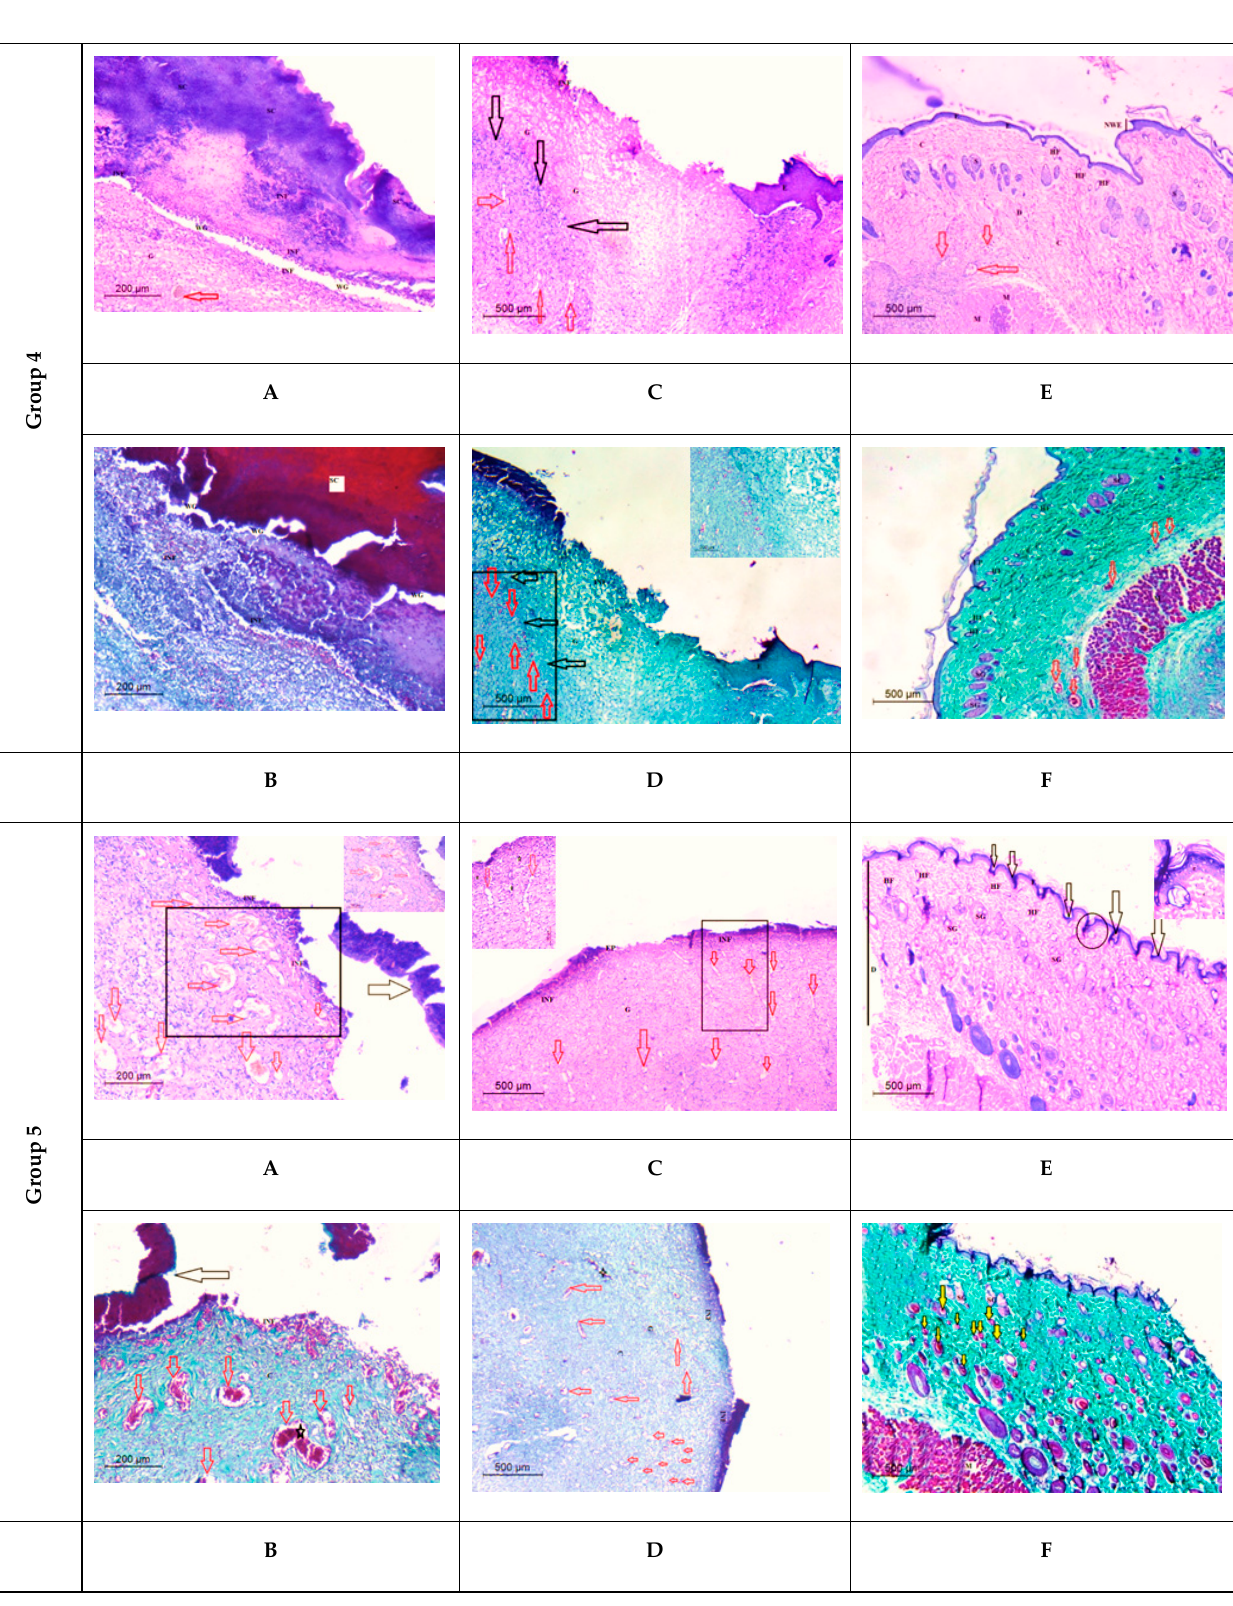
Figure 12. Histological appearance of different wounded rat groups stained with H&E ( A , C , E ) and Massons Trichrome ( B , D , F ) at different time intervals (4th, 8th, and 12th post-wound), in which: SC (Scab); BV (Blood vessel); INF (Inflammatory cells); OE (original epidermis); WS (wound site); G (granulation tissue) yellow arrows (hair follicles); red arrows (blood vessels); ED (Edema); WA